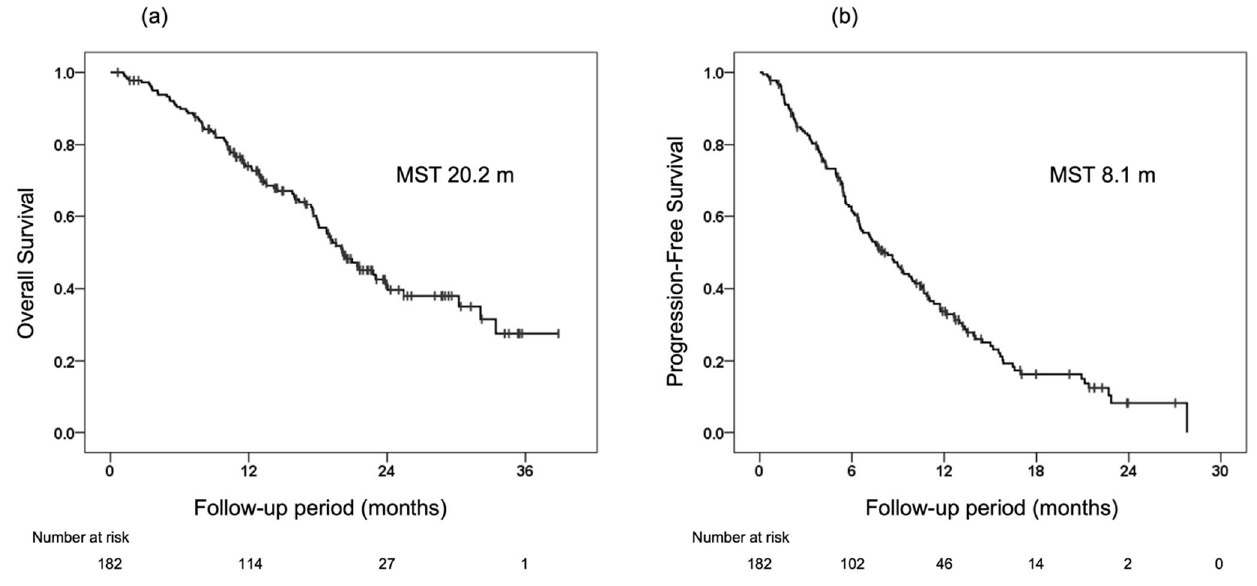
Figure 1. Overall survival (OS) and progression-free survival (PFS) from the initiation of lenvatinib in the 182 patients included in this study. ( a ) OS from the initiation of lenvatinib. ( b ) PFS from the initiation of lenvatinib. Table 2. Radiological responses to lenvatinib.